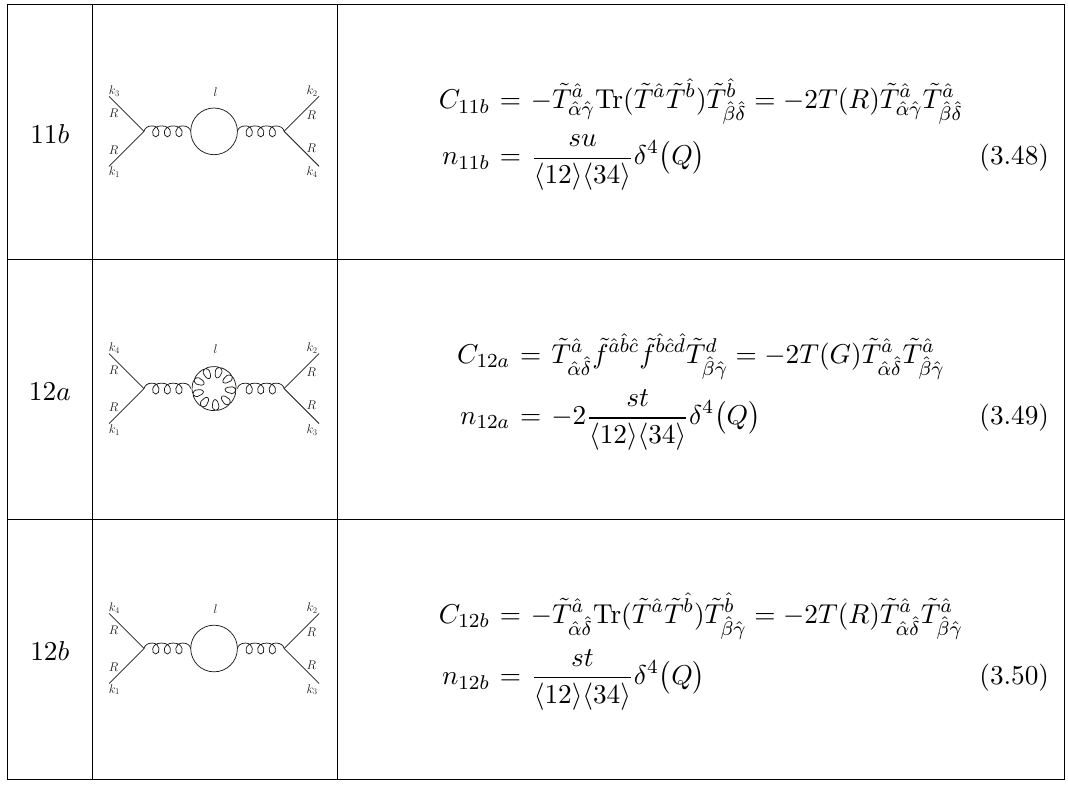
Table 3. Color and numerator factors for the 1-loop superamplitude with four external half- hypermultiplets in case of a pseudo-real representation. Note that all bubbles have symmetry factor S i = 2. Representation matrices with two low indices are de(cid:12)ned as T ^ a where V is the antisymmetric matrix entering the pseudo-reality